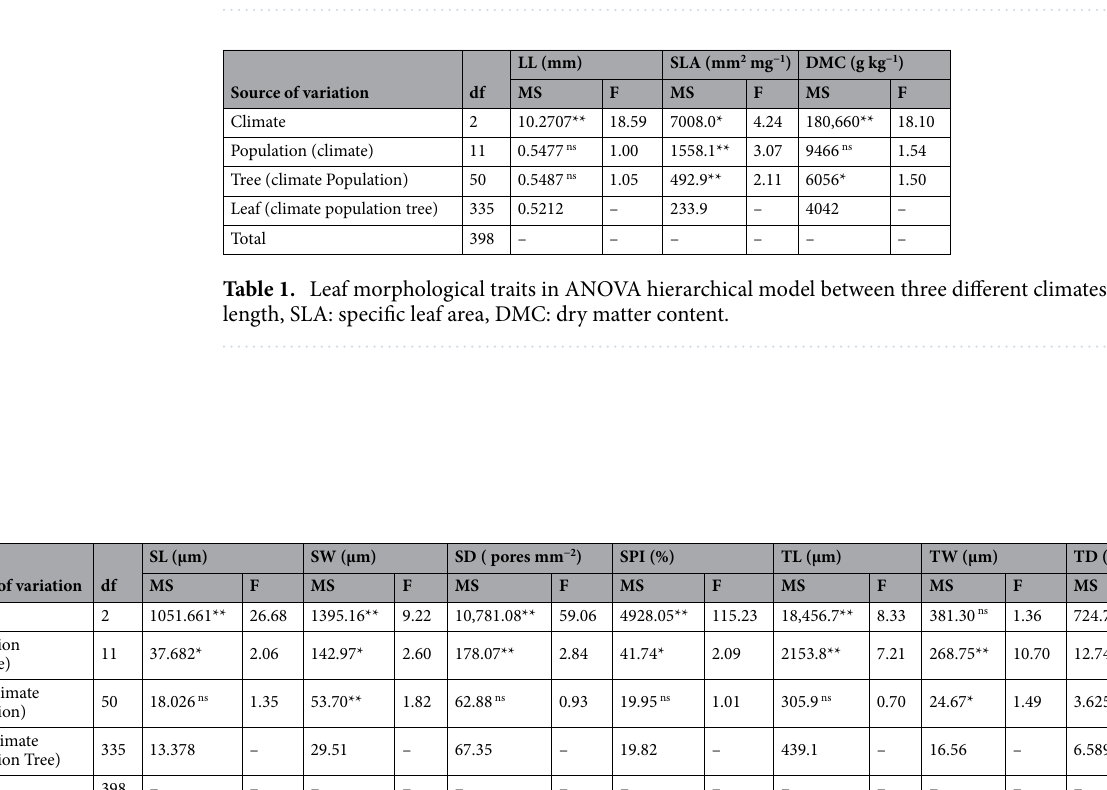
Figure 2. Leaf anatomical traits of Quercus brantii in three different climates. Stomata length (SL), stomata width (SW), stomatal density (SD), stomatal pore index (SPI), trichome length (TL), trichome width (TW) and trichome density (TD). Vertical bars in each column represent Standard Deviation. Lowercase letters indicate significant differences between three climates (Duncan’s multiple range test). The same letters do not significantly differ ( P < 0.05).